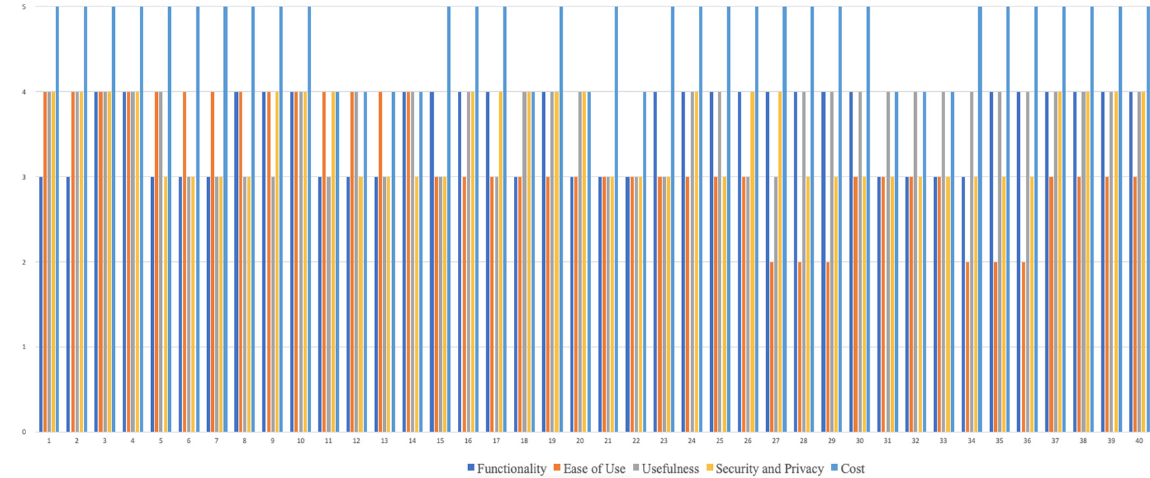
Figure 6. User Trust Evaluation for the Mobile application Version 1.